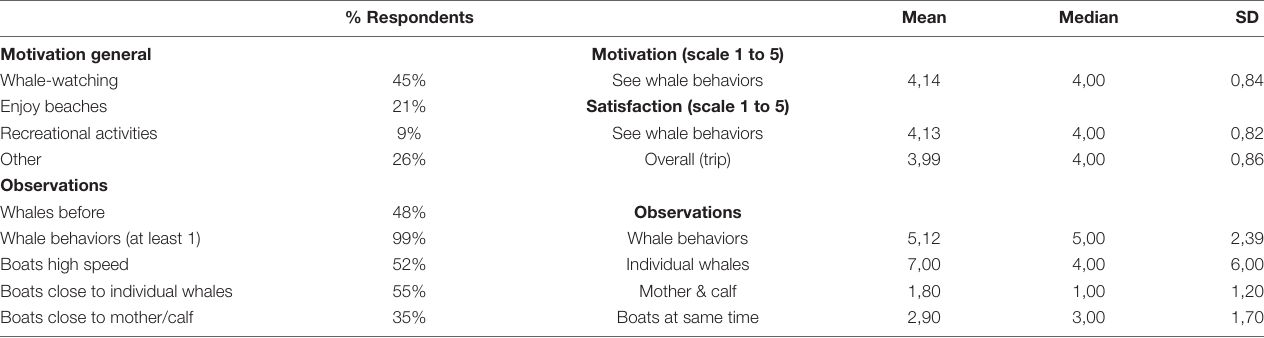
TABLE 3 | Summary of motivations, observations, and satisfaction related to the whale-watching experience.